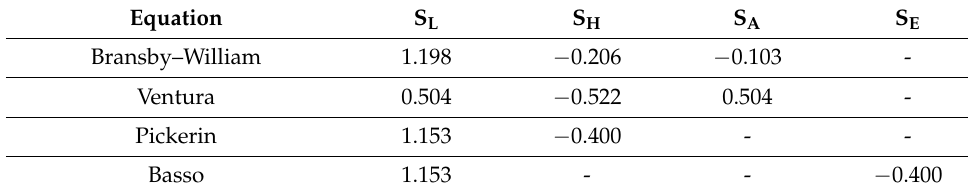
Table 10. Sensitivity coefficients of the methods based on Elevation (category IV).